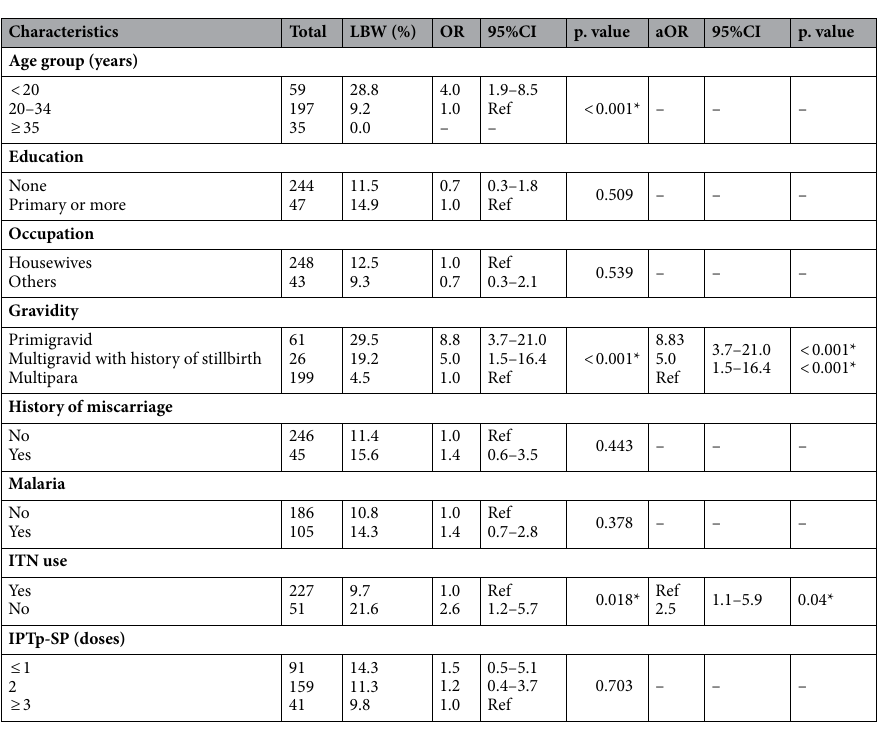
Table 3. Low birthweight prevalence and maternal factors by univariate and multivariate analysis, Burkina Faso (n = 286). SP sulfadoxine-pyrimethamine, CI confidence interval, ANC antenatal care, LBW low birthweight, Ref reference group, ITN insecticide treated bed nets, OR odd ratios, aOR adjusted odd ratios. * Statistically significant.